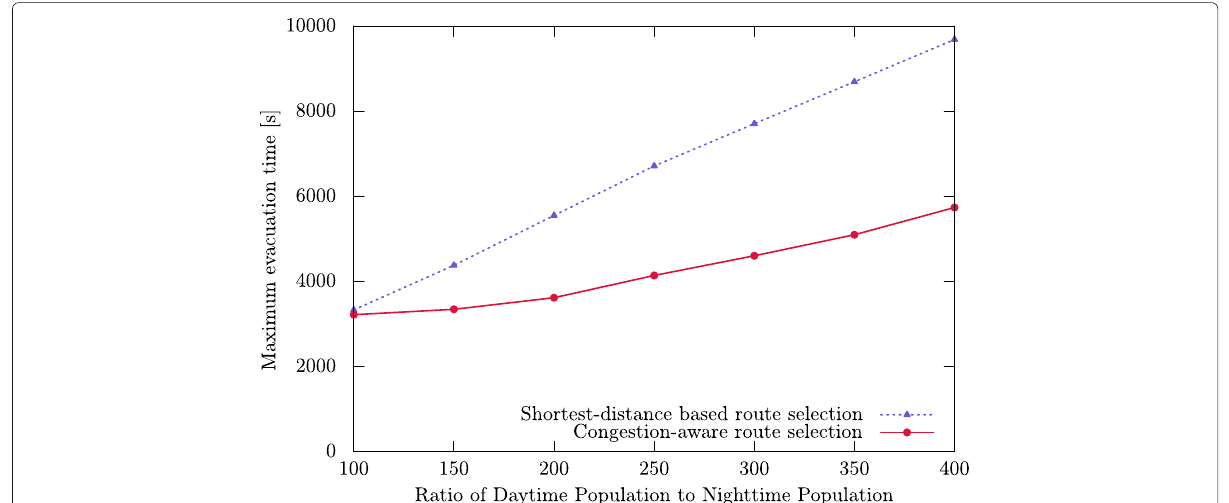
Fig. 8 The ratio of daytime population to nighttime population vs. maximum evacuation time (global